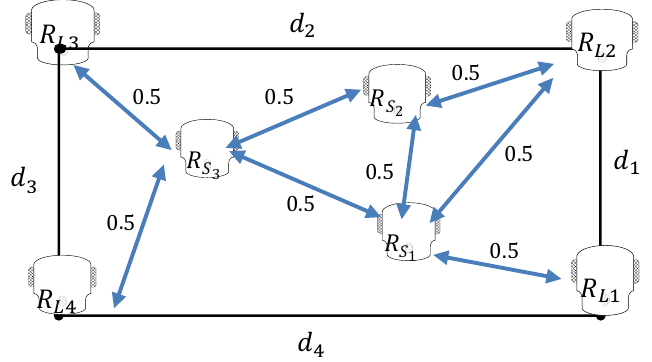
Figure 8 . Distribution of the formation of leaders and